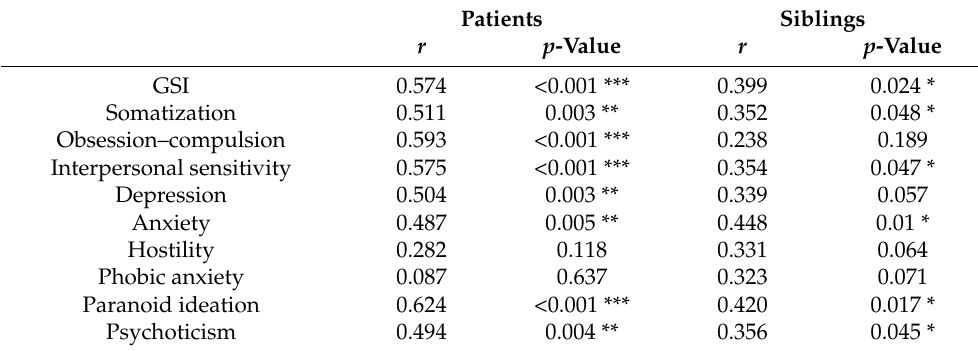
Table 2. Pearson correlations between TAS-20 total scores and SCL-90-R